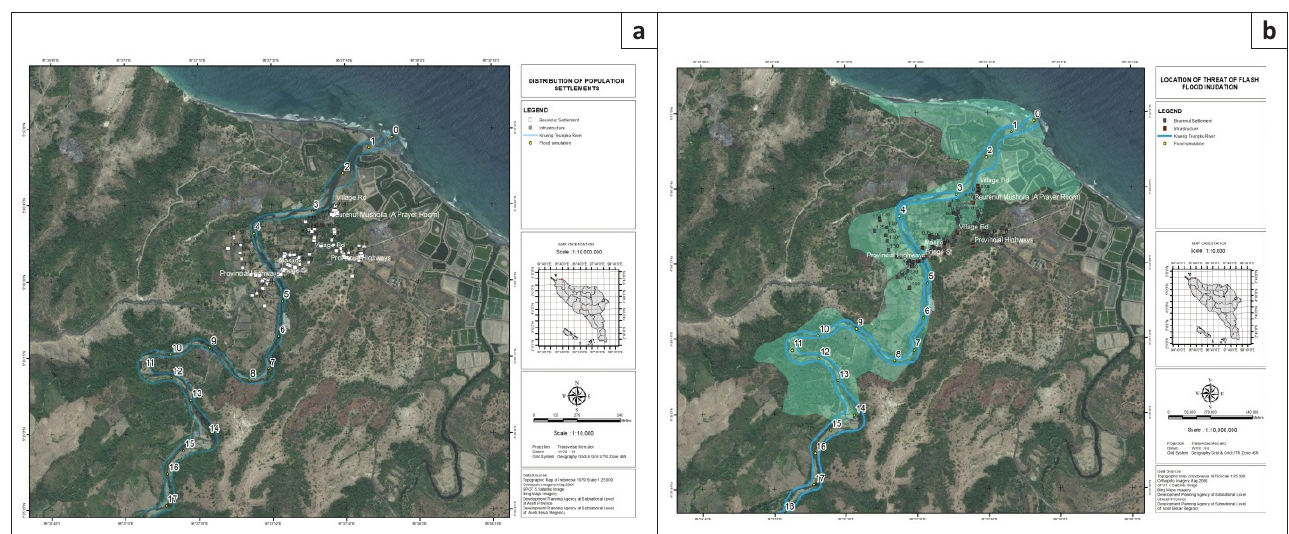
FIGURE 2: Illustration of the population and flash flood propagation. (a) Distribution of population settlements and (b) location of flash flood propagation.